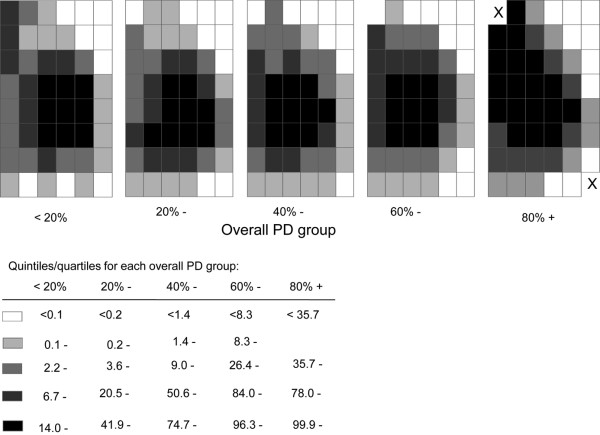
Distribution of mean regional percent density, by level of overall percent density. Distribution of mean regional percent density (PD), as estimated by the average across participants in each overall PD group, at the left exit medio-lateral oblique mammograms. Group-specific quintiles were used to categorise the mean regional PD except in the highest overall PD group, where quartiles were used because of the small number of participants. X, region where no women contributed to that particular analysis.